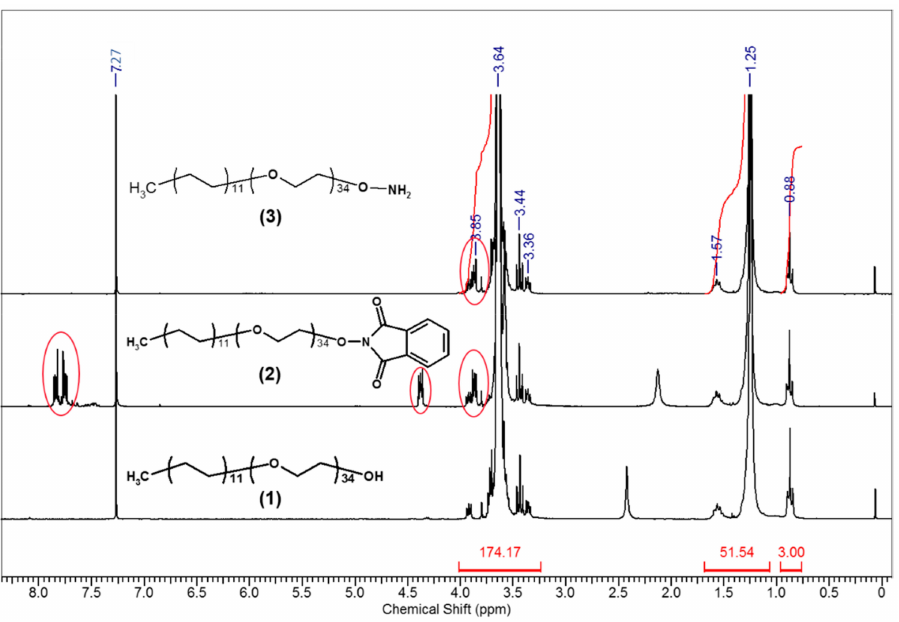
Figure 5. 1 H-NMR of (1) (PE) 11 -(PEG) 34 -OH block-co-polymer, (2) activated with the N-hydroxyphtalimide derivative and (3) the corresponding